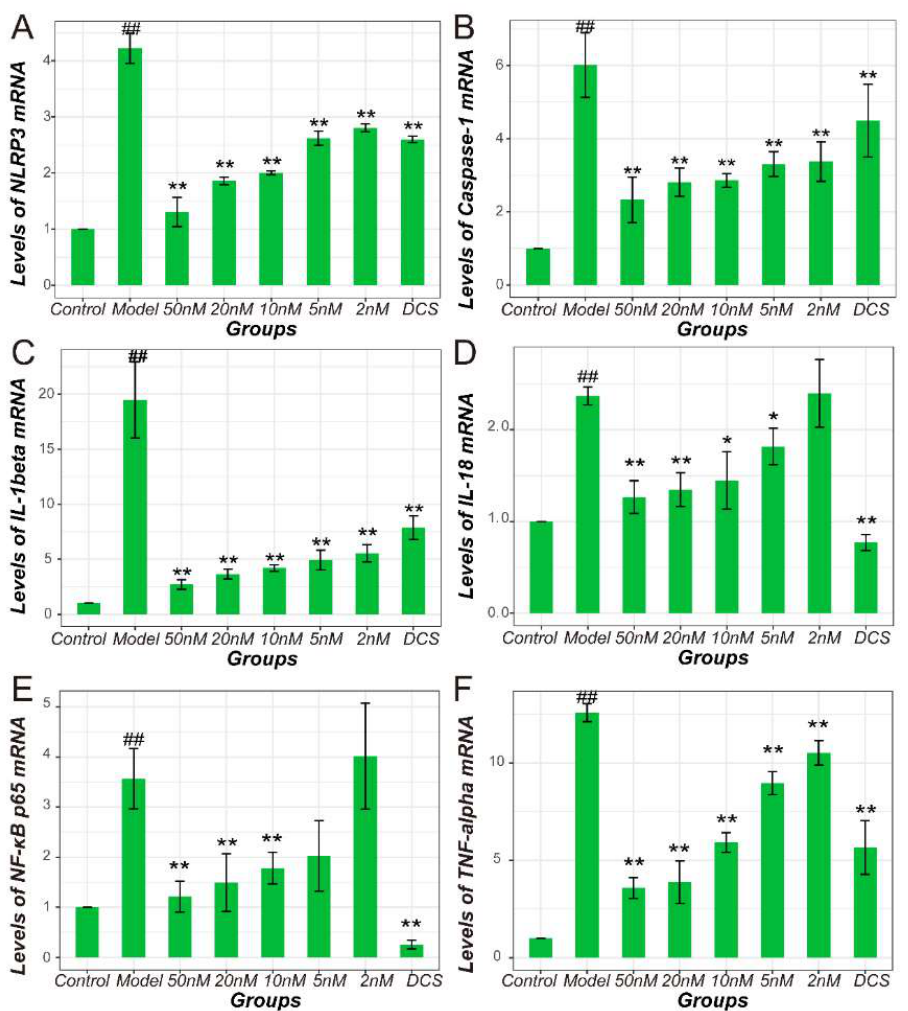
Figure 6. Quantification results of real-time PCR in all cellular groups. Gene expression level of ( A ) NLRP3, ( B ) caspase-1, ( C ) IL-1β, ( D ) IL-18, ( E ) NF-κB p65, ( F ) TNF-α. All values were normalized against β-actin. DCS, Diclofenac sodium. ## p < 0.01 vs. Control. * p < 0.05 vs. Model. ** p < 0.01 vs. Model.